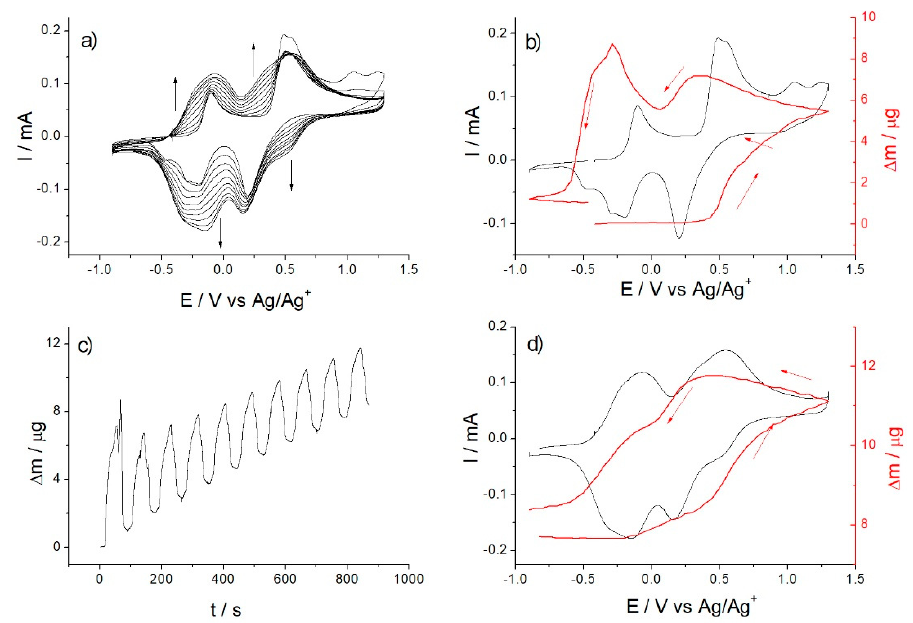
Figure 2. EQCM-monitored polymerization of 0.001 mol L − 1 [Co(Amben)] in 0.1 M Et 4 NBF 4 /EC/DEC performed by 10 CV scans in the potential range between − 0.9 and +1.3 V at a scan rate of 0.05 V s − 1 : ( a ) the current-potential response, ( b ) the current-potential response (black curve) and the corresponding electrode mass variation vs. potential (red curve) during the first CV cycle, ( c ) the electrode mass variation vs. time for 10 consecutive CV cycles, ( d ) the current-potential response (black curve) and the corresponding electrode mass variation vs. potential (red curve) during the 10th CV cycle.